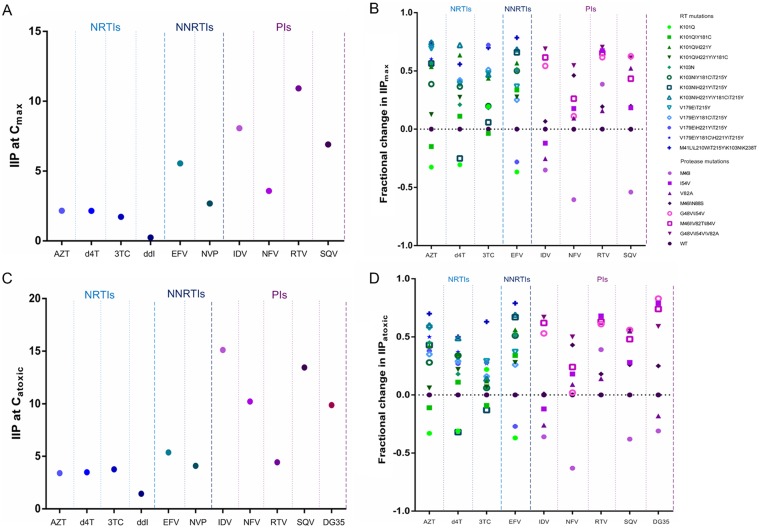
Effect of various viruses on (A, B) IIPmax and (C, D) IIPatoxic toward (A, C) HIVNL4-3 and (B, D) mutant viruses.IIP was calculated using equation (1), with the concentrations used being peak plasma concentrations for IIPmax and the maximum nontoxic concentration for IIPatoxic. Fractional changes in IIP were calculated using equation (3). The drugs tested are grouped by class: NRTIs, NNRTI, and PIs. Within each class, different shapes indicate the various mutants.